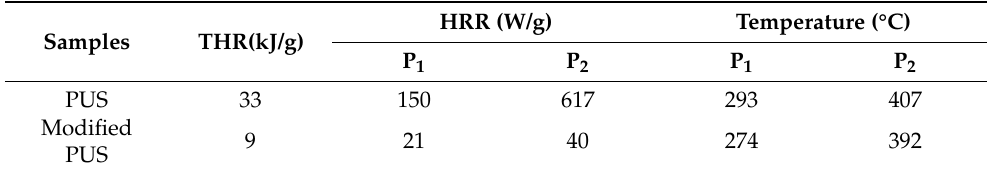
Figure 7. The heat release rate (HRR) and total heat release (THR) curves of PUS before and after modification. Table 4. The total heat release (THR) and the peaks of heat release rate (HRR) curve of PUS before and after modification.